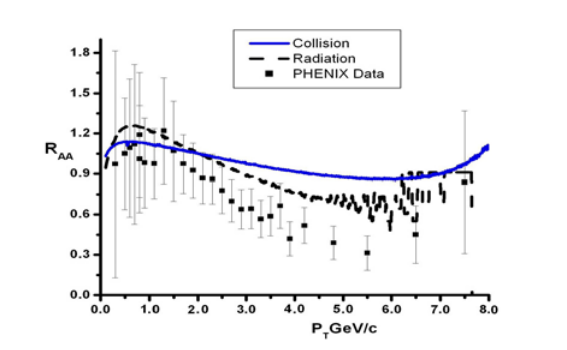
Figure 2: Nuclear suppression factor R AA due to collisional and radiation energy loss separately as functions of P T . Used parameters are: τ 0 = 0 . 33 fm/c, T 0 = 0 . 375 GeV, α s = 0 . 3 , T c = 0 . 175 GeV